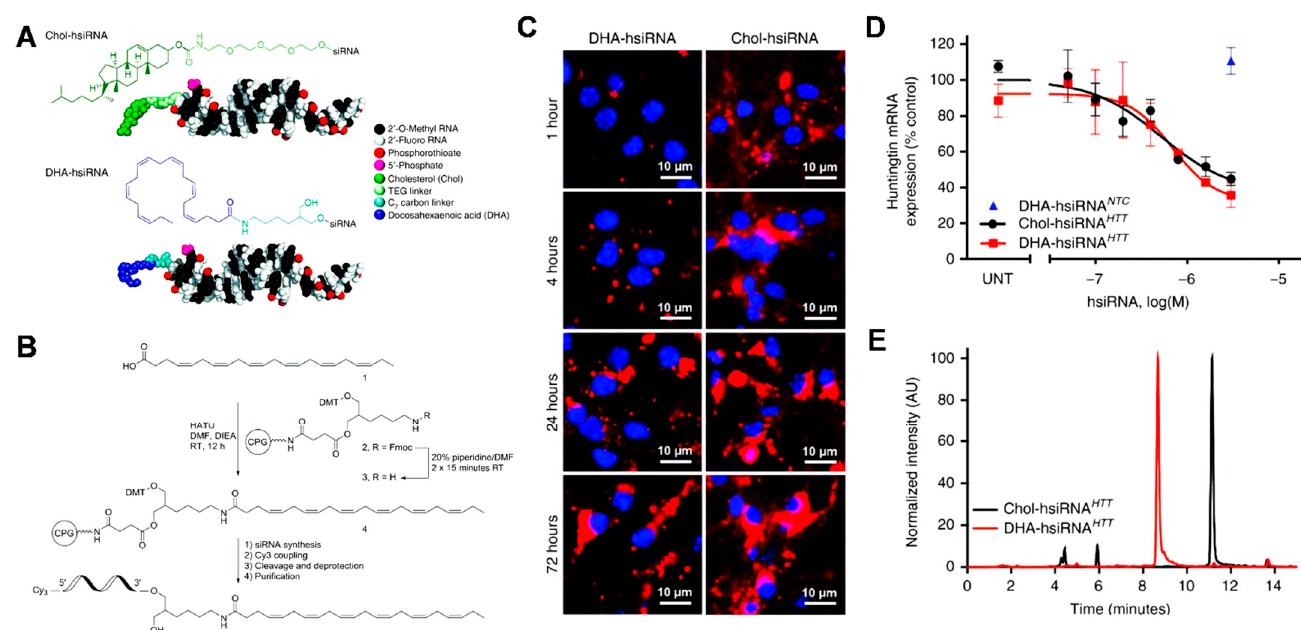
Figure 3. Schematic illustration of the construction of cholesterol-conjugated miRNA. ( A ) Fully chemically stabilized hsiRNA with either docosahexaenoic acid (DHA) or cholesterol (Chol) bioconjugates at the 3 ′ -end of the sense strand; ( B ) Solid-phase synthesis of DHA-conjugated hsiRNA. Htt, Huntingtin; ( C ) Intracellular uptake of Cy3-DHA-hsiRNA and Cy3-Chol-hsiRNA; ( D ) Gene expression detection after hsiRNA incubation; ( E ) High-performance liquid chromatography (HPLC) traces of DHA-hsiRNAHTT and Chol-hsiRNAHTT following reverse phase chromatography. Reproduced with permission [151].